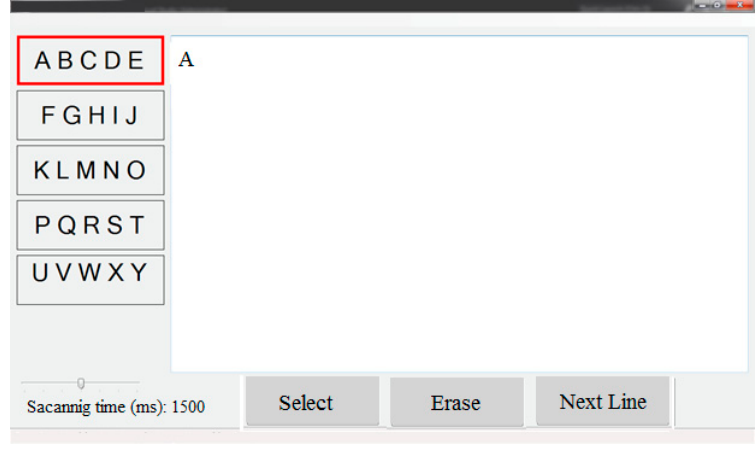
Figure 3. Phase-Composer main interface.